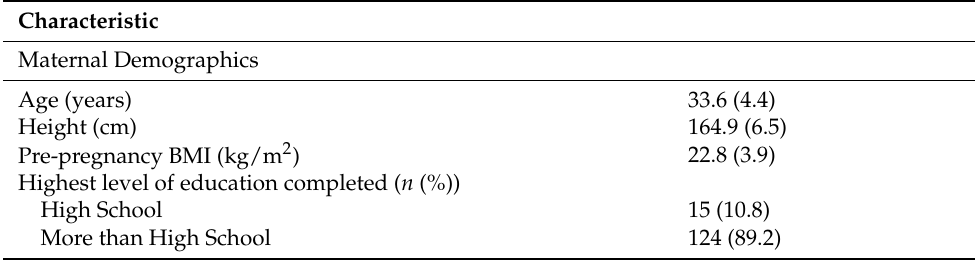
Table 1. Maternal, including diet, and neonatal